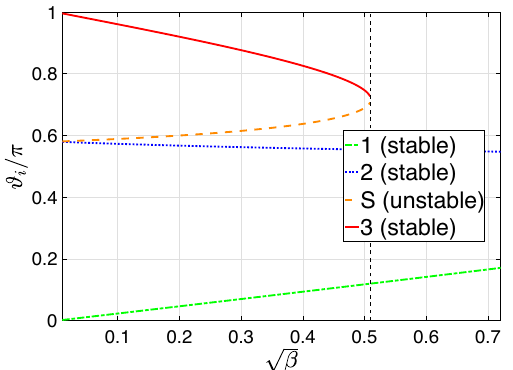
arctan ( L ( i ) π/ 2 ) as a function of √ β for the i -th equilibrium L ( i ) x Figure 8. The angles ϑ i z / = − 1, 2, 3, S β crit . The points numbers correspond to the point, i . Black dashed line corresponds to β = ∈ { } (cid:31) (cid:31) 40 , α 2 /α 1 0.5 , �/α 1 ones in Fig. 6. Here the parameters are as follows: N (cid:31) (cid:31) = = g